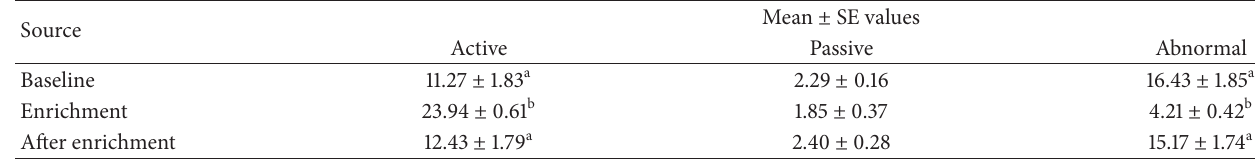
Table 2: Effect of environmental enrichment on behavioural categories.